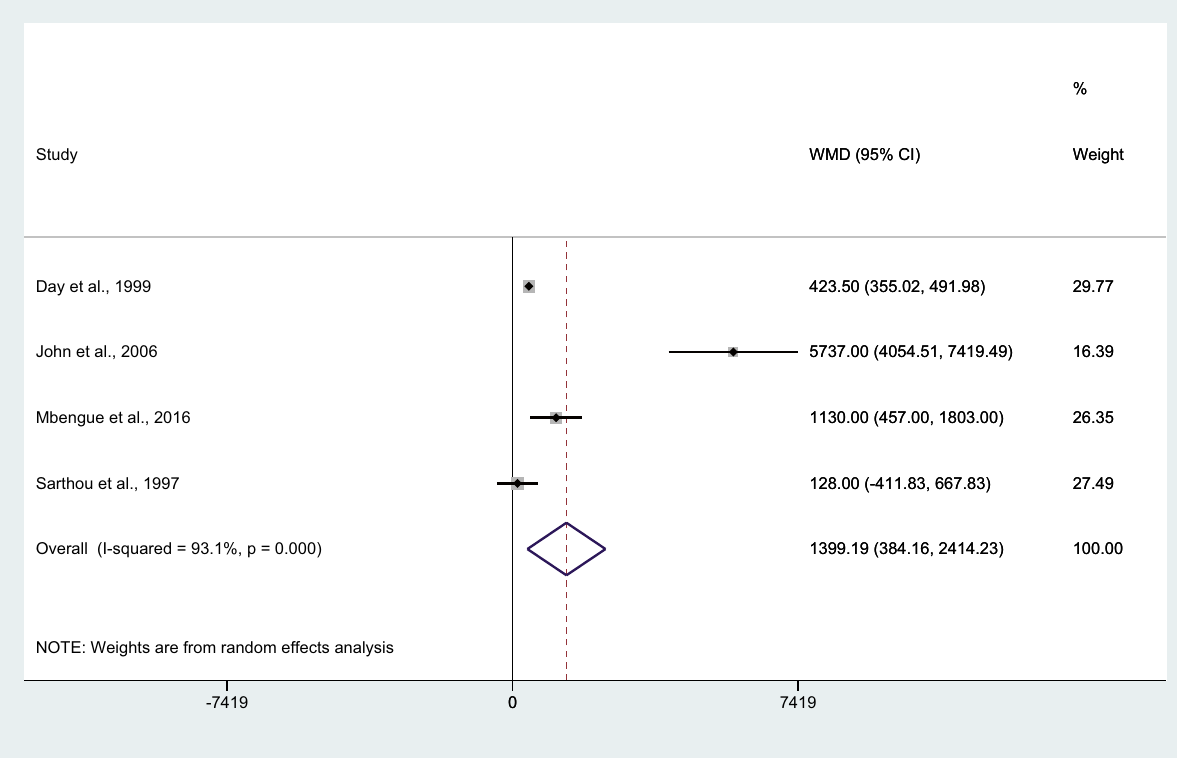
Figure 15. Differences in IL-6 levels between patients who died and those who survived. Abbreviation: WMD, weighted mean difference; CI, confidence interval; black diamond symbol, point estimate; solid line in the middle of the graph at 0, zero effect size; Dashed red line: pooled WMD between the two groups; I 2 , level of heterogeneity; P = 0.000 or less than 0.05, significant heterogeneity.